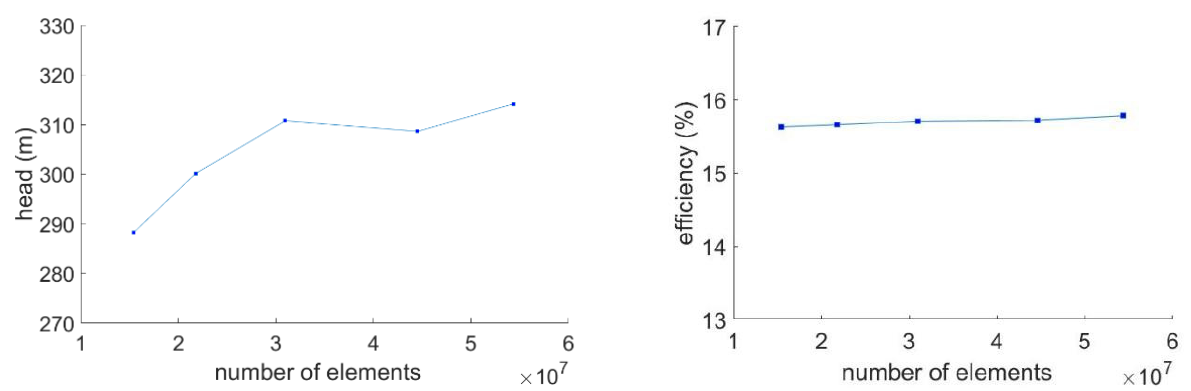
Figure 3. Grid independence verification diagram.